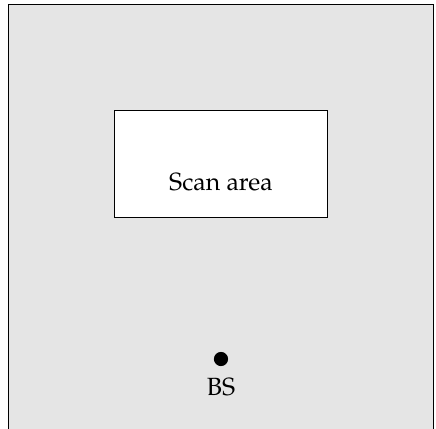
Figure 3. The simulated search and rescue scenario. In the white rectangle area the searching UAVs perform the search task and are confined within that area. The other nodes (delivery UAVs) are involved in other tasks, covering the larger gray area. The base station (BS) is located outside the scanning area, but within the larger